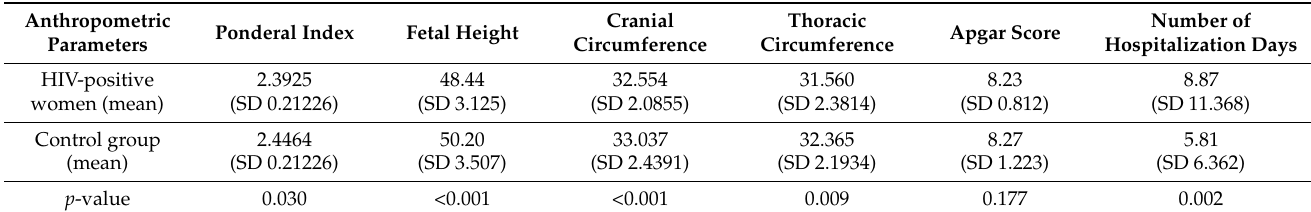
Table 3. Anthropometric parameters in infants born from HIV positive patients compared to control